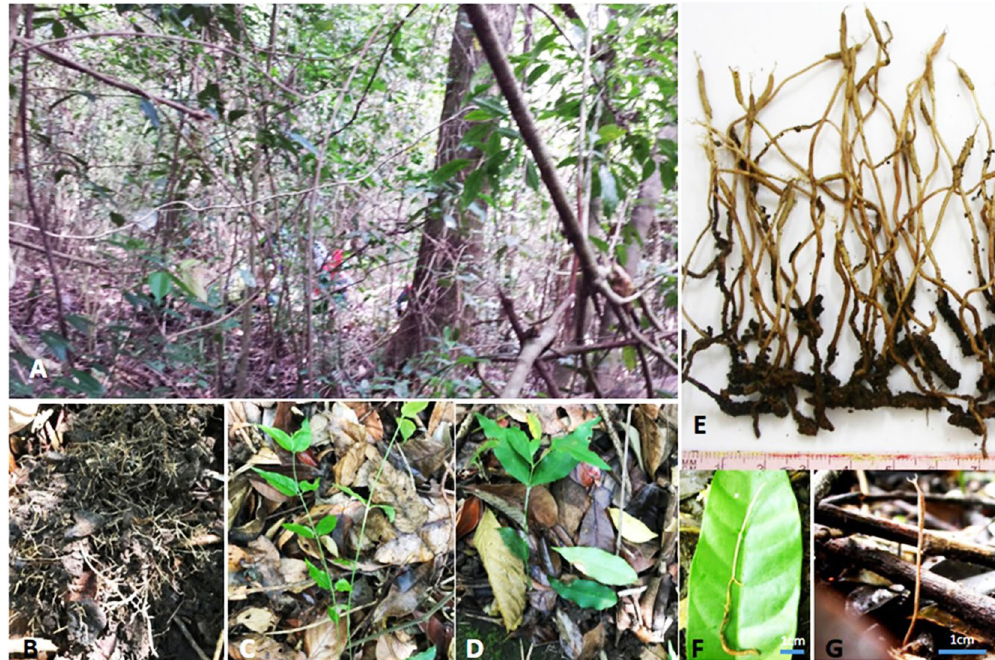
Figure 1. Overview of Ophiocordyceps langbianensis . ( A – D ) Ecology of collected plots; ( E ) Stroma developing from the head of hosts; ( F ) Immature stromata of fungus emerging from the larva of Coleoptera; ( G ) Stromata in moist soil surrounded by dried leaves.